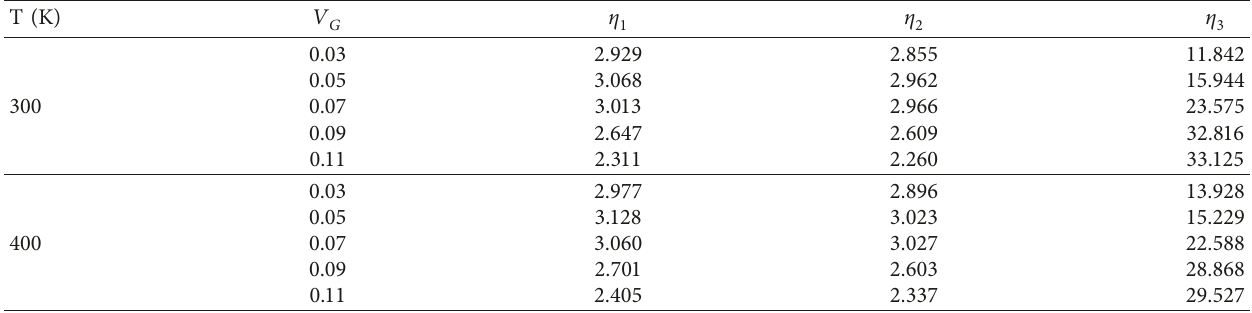
Table 2: Efficiency parameters related to volume component of